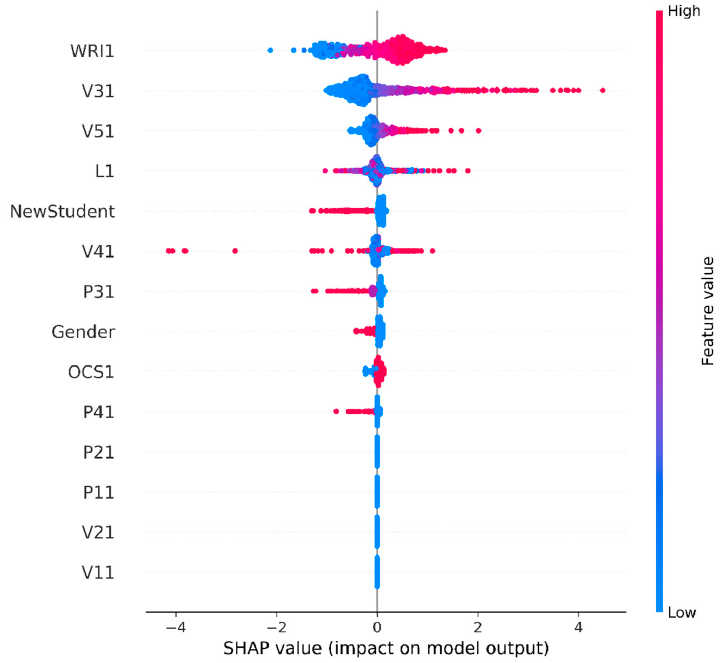
Figure 8. KernelSHAP values of the MLP regressor ( D 1 dataset).